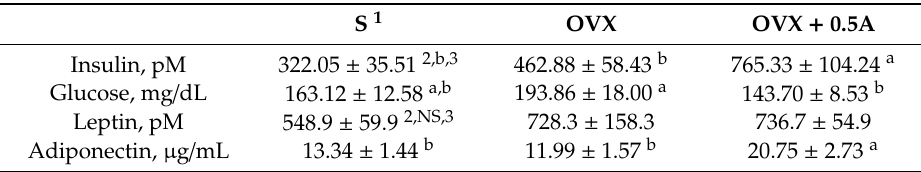
Table 3. E ff ect of A. pilosa on serum metabolic parameters. Table 3. Effect of A. pilosa on serum metabolic parameters.